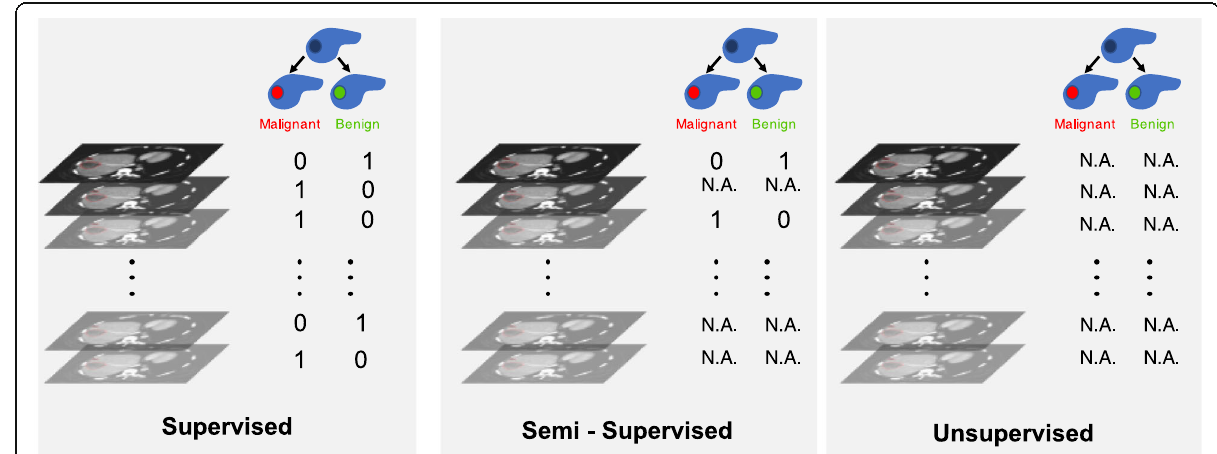
Fig. 4 Types of learning. With supervised learning, the number of inputs (CT images in this example) equals numbers of targets (malignancy status of a lesion here). With semi-supervised, the number of inputs is greater than the number of targets (dataset includes unlabeled samples). With unsupervised learning, none of the inputs are labeled (e.g . , clustering, manifold learning, restricted Boltzmann machines). N.A. indicates not available